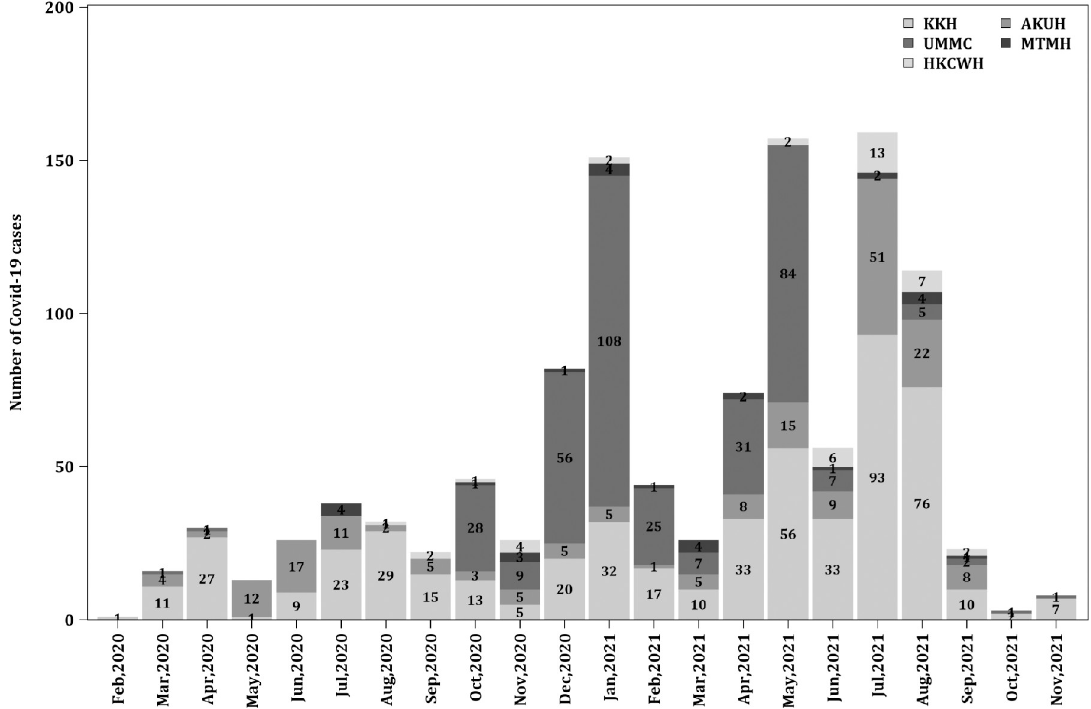
Fig 1. Stacked bar chart of COVID-19 cases from respective sites over the duration of the pandemic. KKH–KK Women’s and Children’s Hospital. UMMC–University Malaya Medical Center. HKCWH–Harapan Kita Women’s and Children’s Hospital.